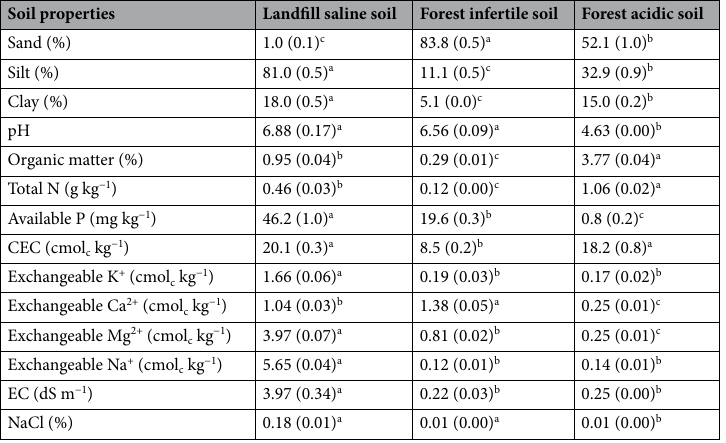
Table 4. Soil properties of three different soil types (landfill saline soil, forest infertile soil, and forest acidic soil) before fertilizer treatment. Standard errors are shown in parentheses (n = 3). Mean values with the same letters are not significantly different within each soil property across three soil types (p < 0.05; Tukey’s HSD